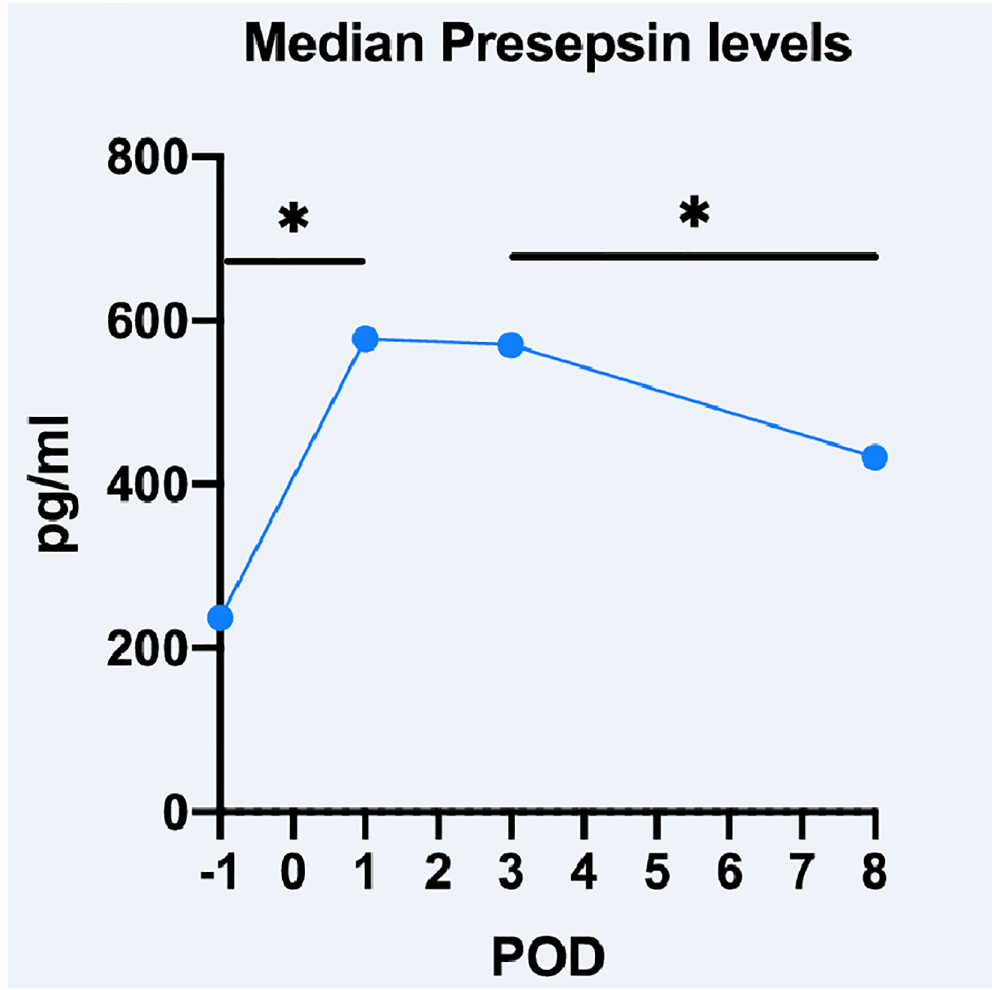
Fig 1. Perioperative dynamics of